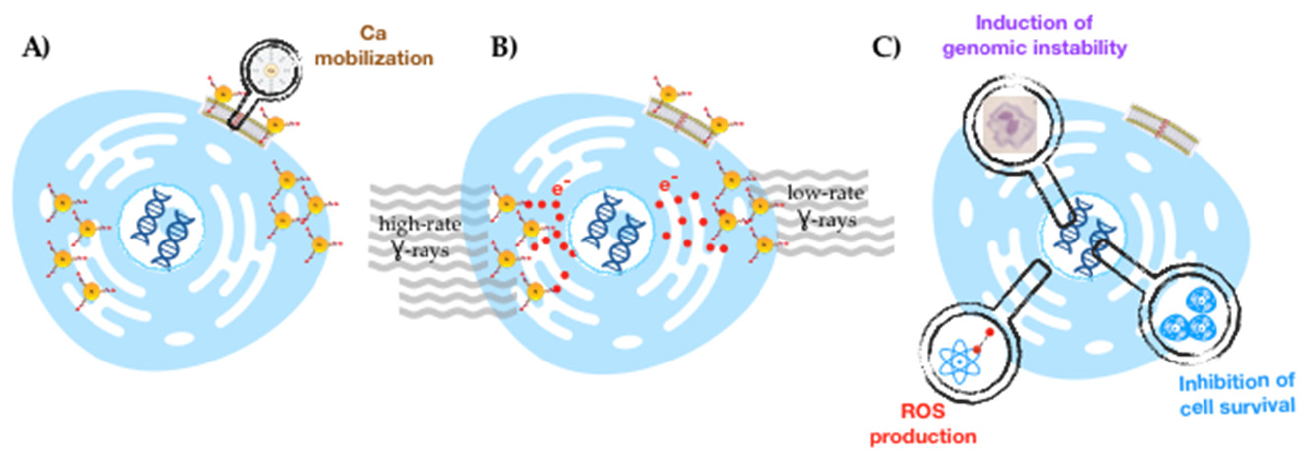
Figure 1. Schematic drawing of the delineated strategy for a selective radiosensitization of prostate cancer cells with target-specific AuNPs: selective GRPR-mediated cellular uptake ( A ), followed by irradiation with γ -photons (at low and high dose rates) ( B ) to obtain enhanced radiobiological effects ( C ).